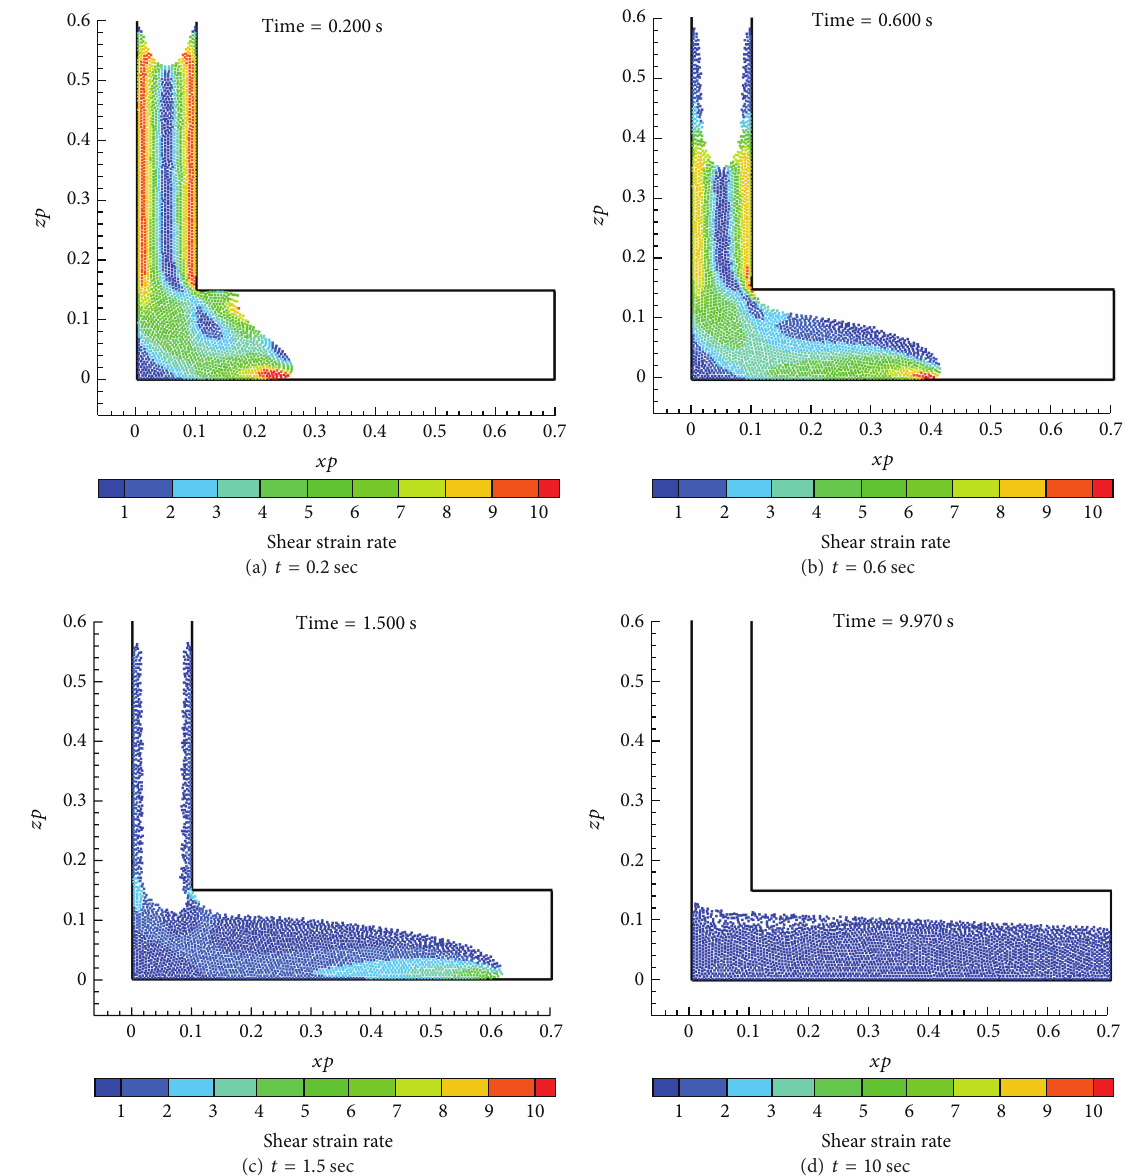
Figure 8: Simulation of L-box testing for SCC with shear strain rate